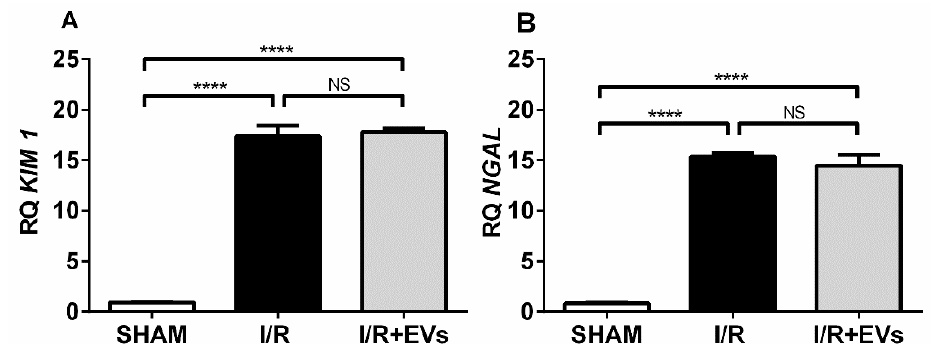
Figure 6. The expression (relative quantification) of the renal injury biomarkers 24 h after I/R are not modified by EVs. ( A ) KIM-1 . ( B ) NGAL . The expression of the genes was investigated from total RNA extracted from cortex corticis. The bars represent mean ± SEM that were compared using one-way ANOVA followed by Tukey’s test. The experimental groups are indicated on the abscissae; n = 4 (SHAM), n = 7 (I/R), n = 5 (I/R + EVs), for both biomarkers. **** p < 0.0001; NS: not significant.